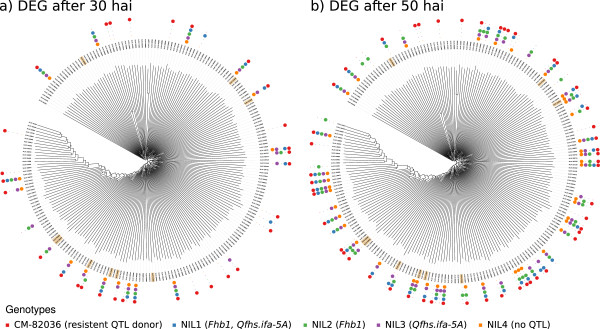
Regulation of UGT genes at different time points. Dendrograms display differential expression of UGT genes (a) 30 and (b) 50 hours after inoculation (hai) with F. graminearum spores. Genes that are significantly changed for the given genetic background (NIL1-NIL4, CM-82036) in response to F. graminearum are indicated in the respective colour. UGT genes homologous to the previously identified DON-detoxification UGTs in B. distachyon are highlighted. Note that the clades within dendrogram do not necessarily reflect groups or families of related genes, but are only used for presentation purposes.